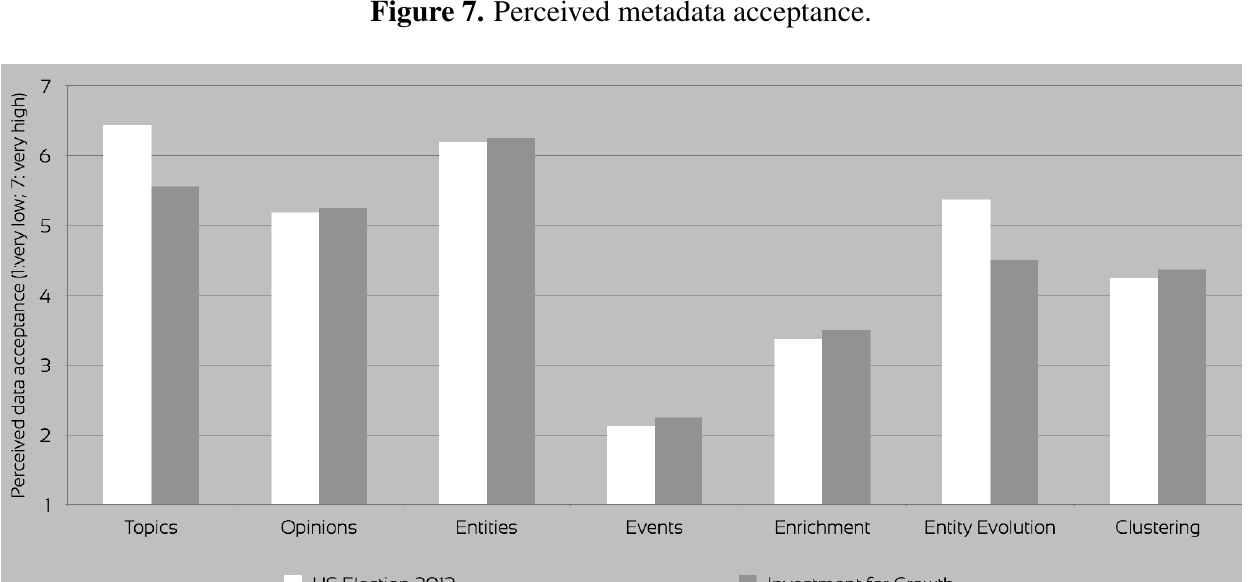
Figure 7. Perceived metadata